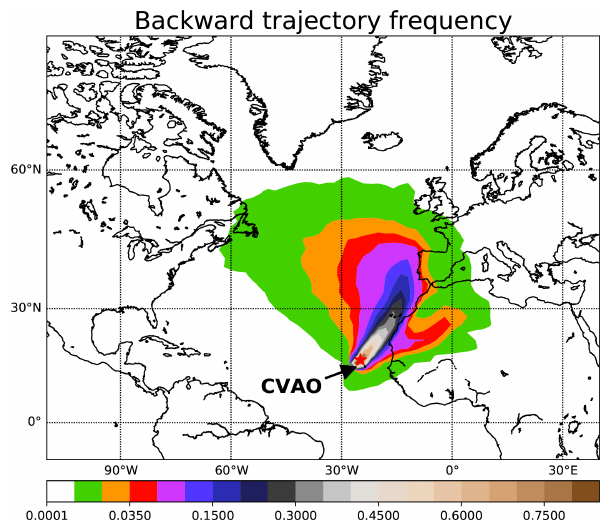
Figure 6. Relative frequency of backward trajectories arriving at CVAO.